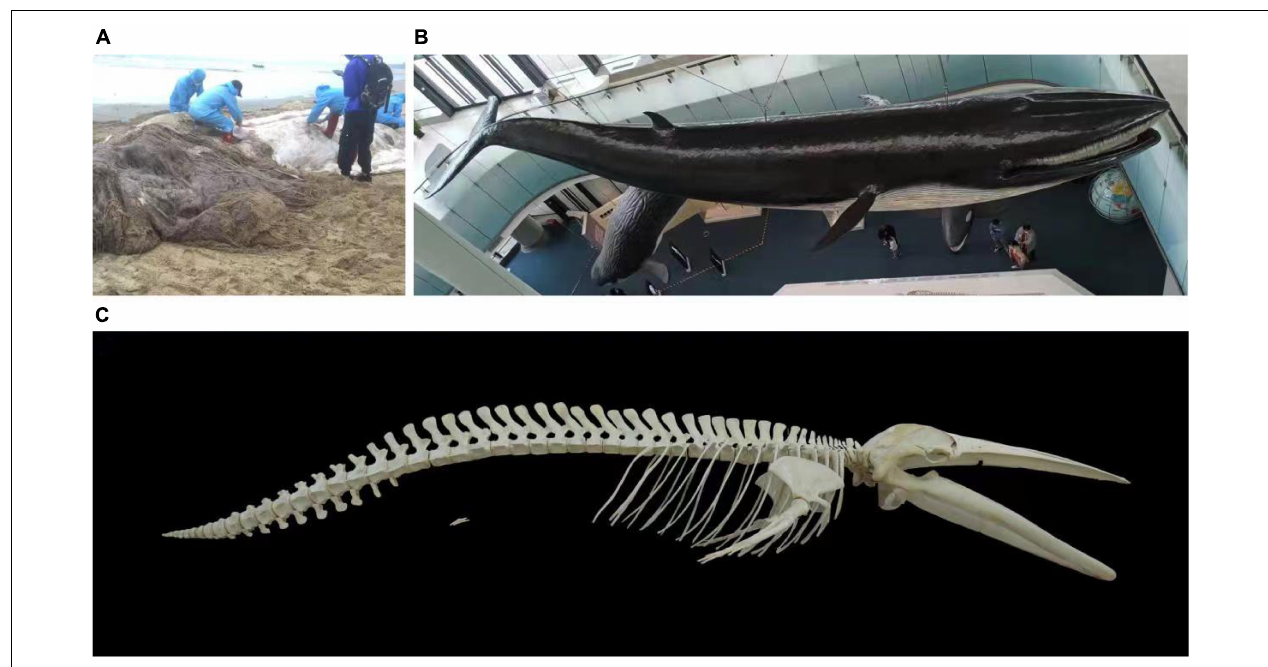
FIGURE 1 | Photographs of the museum whale specimen in this study. (A) Uncovering the stranded specimen; (B) whole body post-treatment, with characteristic three rostral cephalic ridges used as morphologic identification criterion; (C) complete skeleton on display in museum.